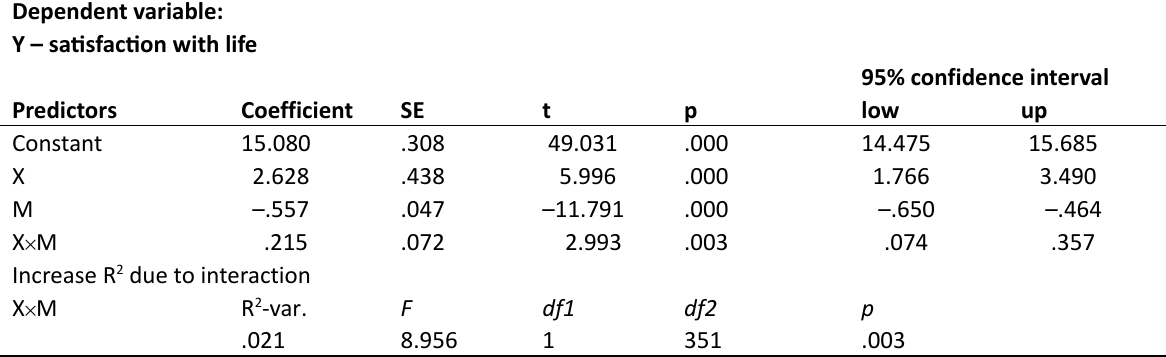
Table 2. Regression analysis of satisfaction with life (Y) as a function of perceived stress (X) and physical exercises (M),